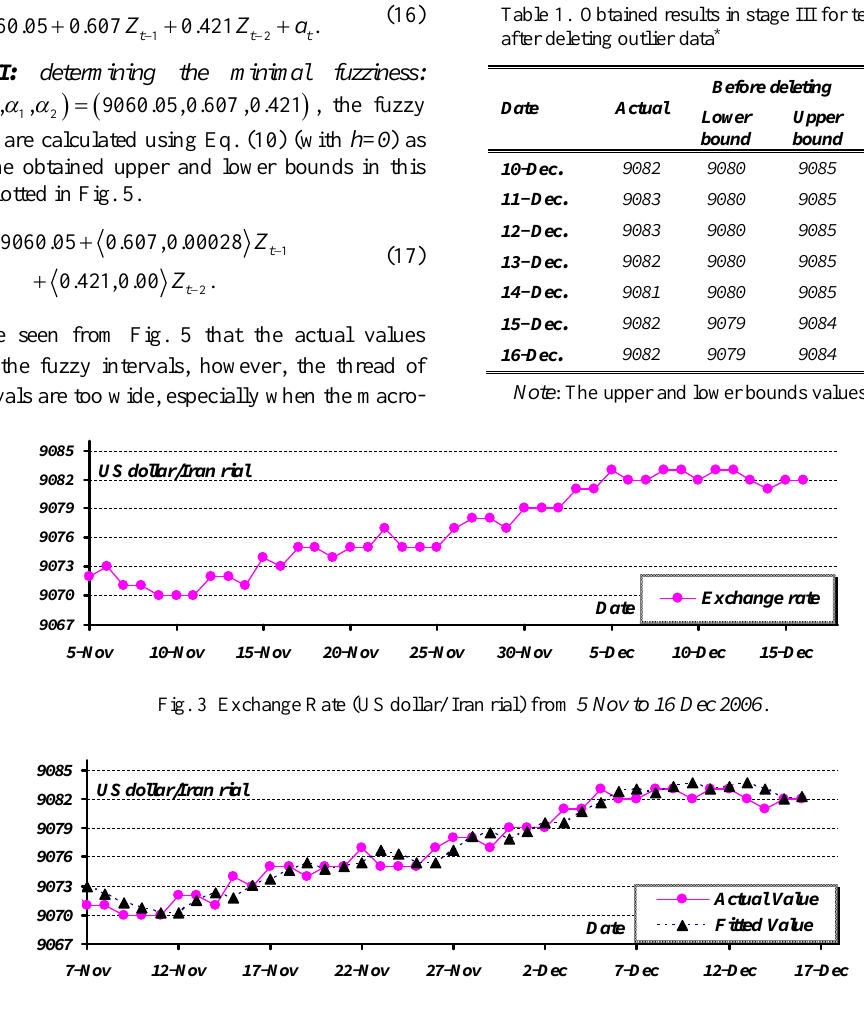
Fig. 4 ARIMA fitted values for US dollar against Iran rial exchange